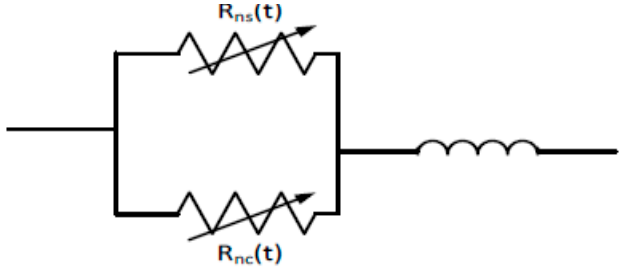
Figure 12. Resistive type SCFCL.